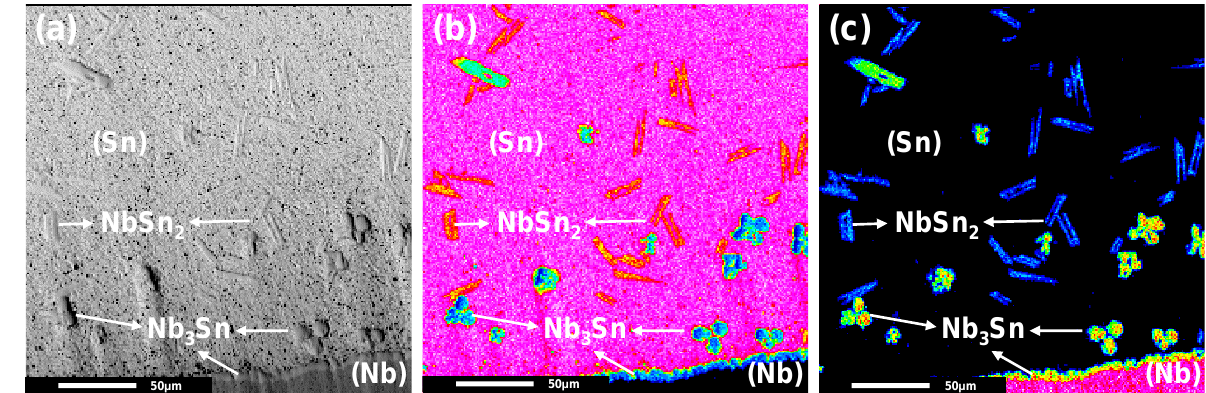
Figure 7. ( a ) BSE image, ( b ) mapping distribution of Sn, and ( c ) mapping distribution of Nb of Nb/Sn LSDC annealed at 1200 °C for 2 h